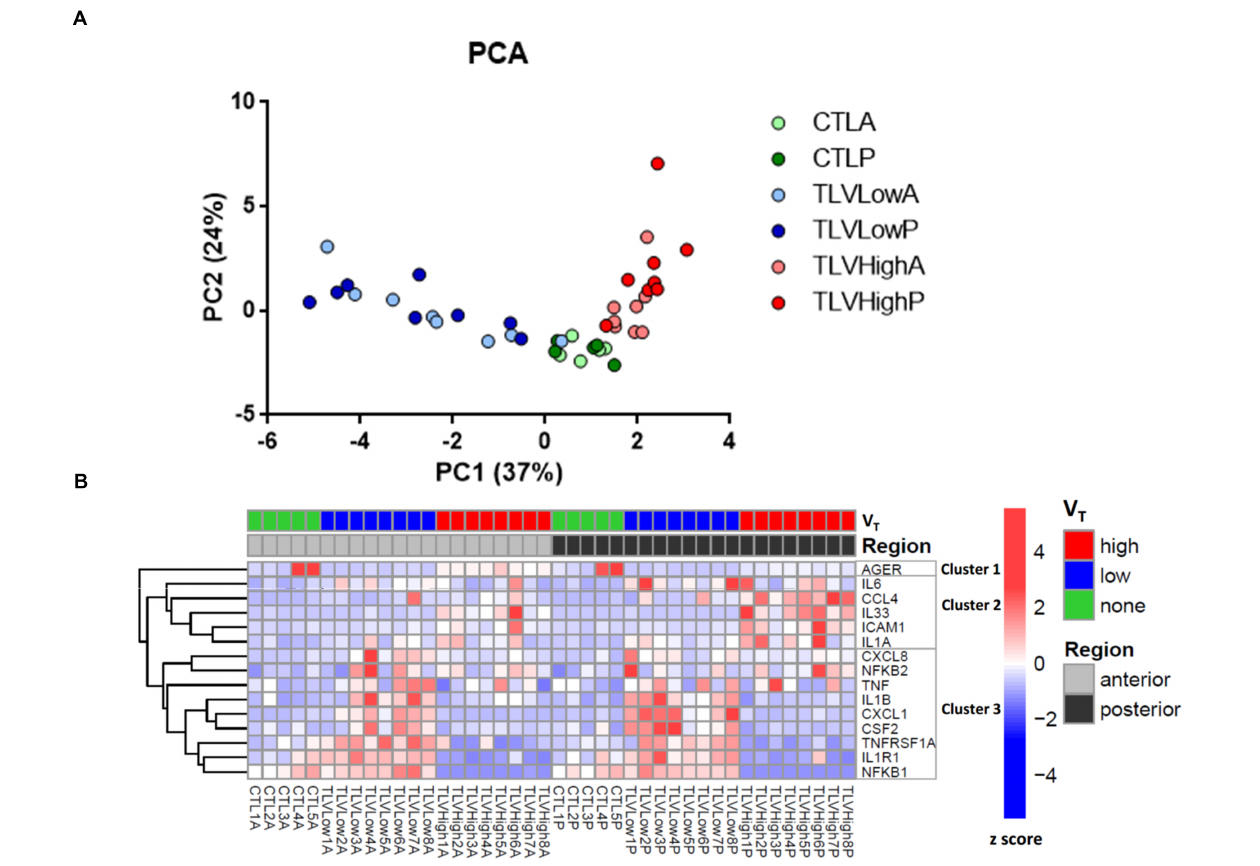
FIGURE 4 | Inflammatory gene expression analyses. (A) Principal component analysis of gene expression data in both anterior (Light colored dots) and posterior (Dark colored dots) lung samples from unventilated, L-V T (TLVLow) and H-V T (TLVHigh) lambs. Distance between dots approximates gene-expression pattern differences among experimental conditions/lung regions; the closer the dots, the closer the expression levels for each linearly uncorrelated gene group (i.e., principal component). (B) Heatmap and unsupervised clustering of selected gene expression in the anterior and posterior lung regions in L-V T , H-V T or unventilated lambs (CTL). Colors indicate expression z -score after normalization on housekeeping